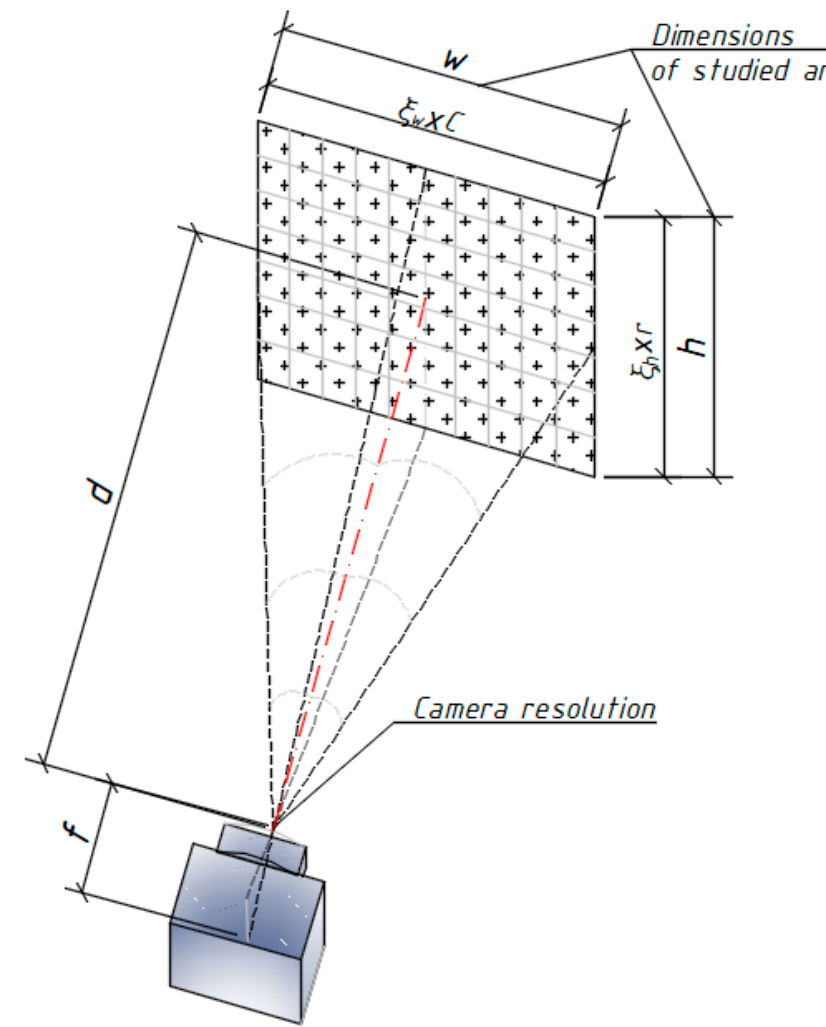
Figure 4. Schematic diagram of experimental setup with application of the DIC technique.